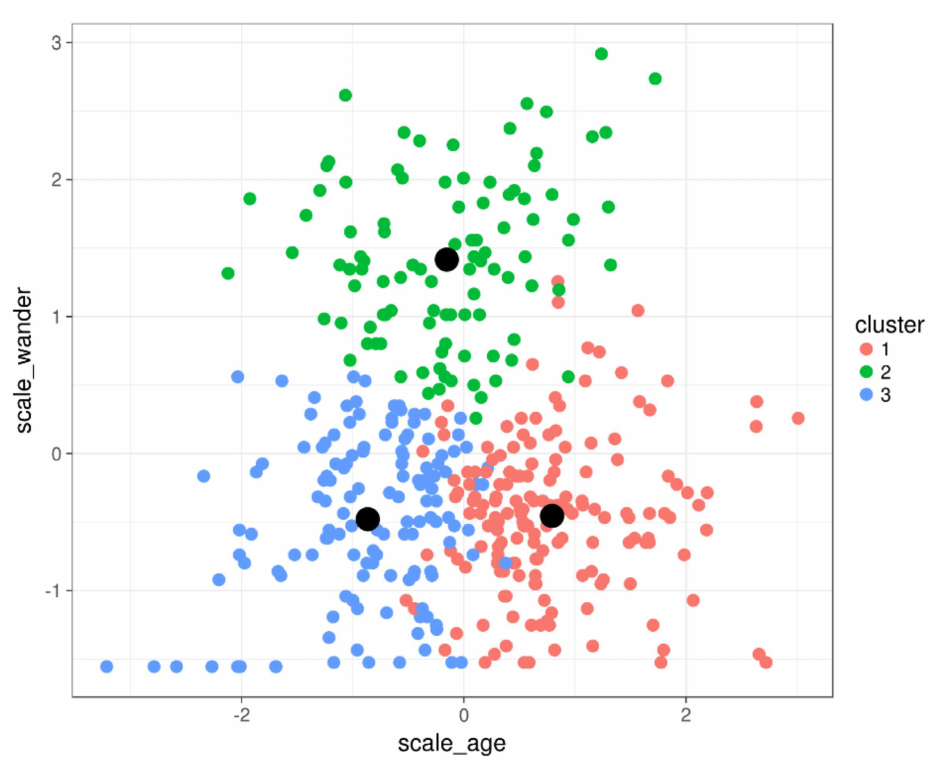
Figure 2. Result from clustering algorithm for three clusters indicated in three colors (red, green, blue). The centroids for each cluster are indicated with a black